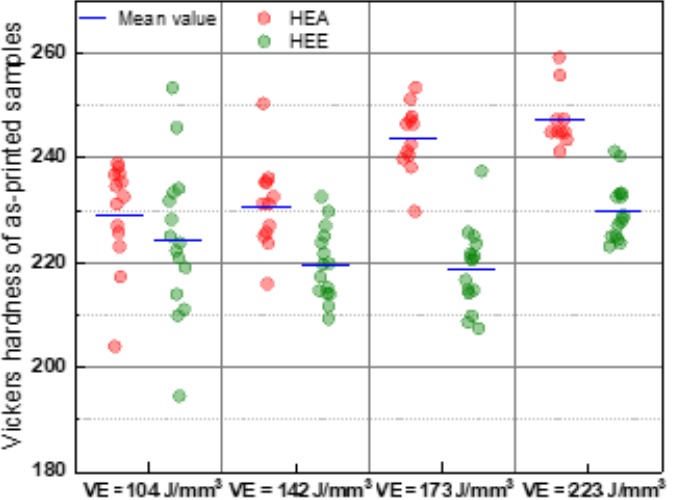
Figure 14. Vickers hardness of as-printed samples with VE variation from 69 to 173 J/mm 3 .